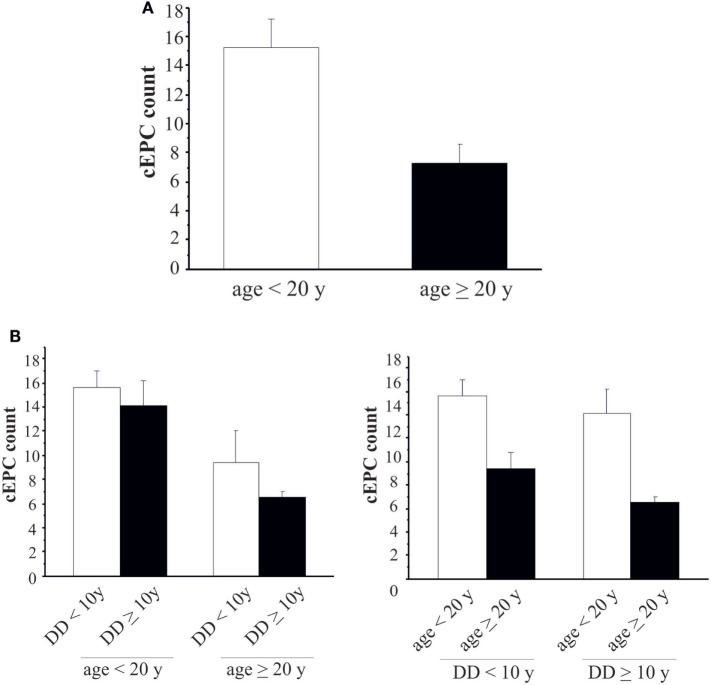
(A) Circulating endothelial progenitor cell (cEPC) counts in type 1 diabetes mellitus patients of different age groups (white bar: age <20 years; black bar: age ≥20 years). Data are reported as mean ± SEM; p = 0.004. (B) Histograms summarizing cEPC levels in patients belonging to the different age and disease duration groups. Data are reported as mean ± SEM. Left histogram: p = 0.689 and p = 0.418, Mann–Whitney U test. Right histogram: p = 0.153 and p = 0.061, Mann–Whitney U test.